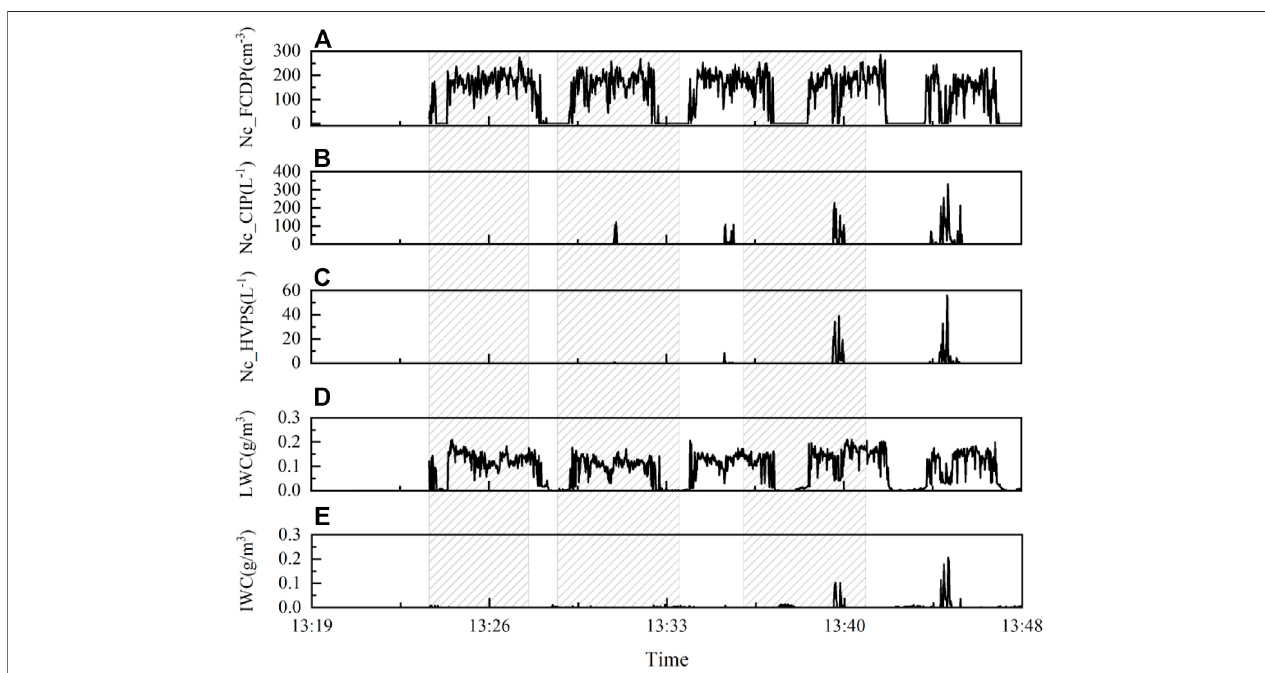
FIGURE8| Thetemporalchangeofcloudparticlenumberconcentrationmeasuredbyfastclouddropletprobe,cloudimagerprobe,andhigh-volumeprecipitation spectrometer as well as liquid water content and ice water content measured by Nevzrov hotwire, where the seeding periods were marked as shaded areas.